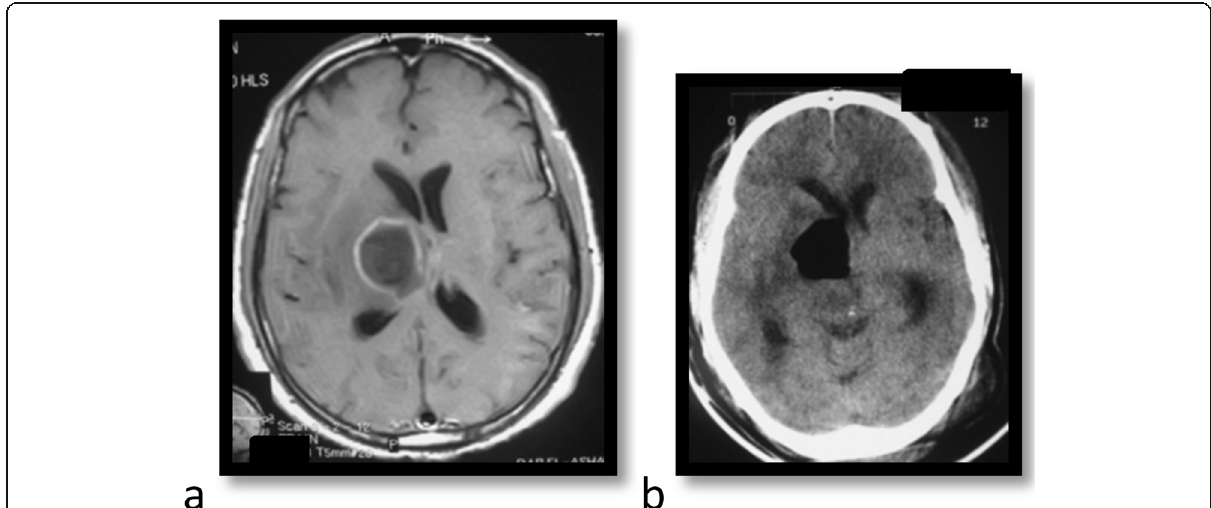
Fig. 4 a : On the left MRI axial T1 with contrast showing right thalamic abscess and b on the right post stereotactic aspiration CT showing right thalamic abscess aspiration